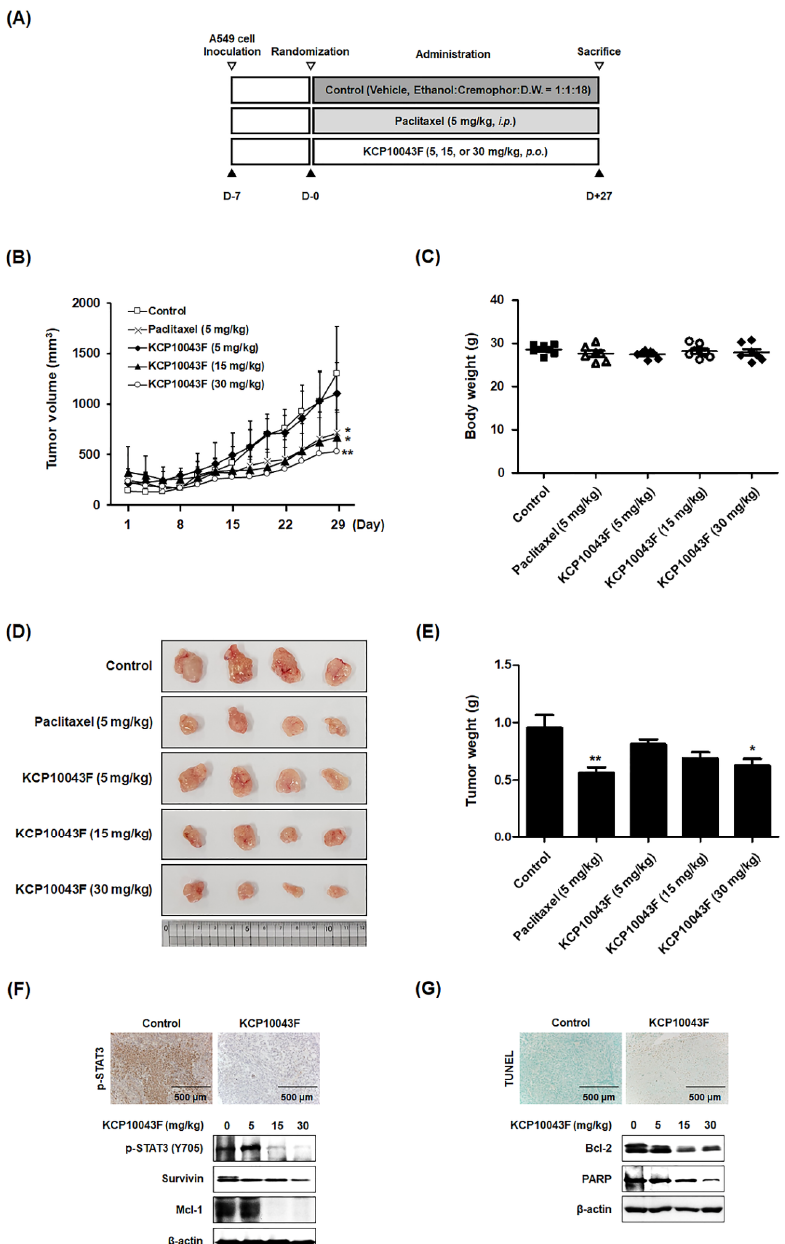
Figure 7. Antitumor effects of KCP10043F in human lung cancer xenograft mouse model by the induction of apoptosis. ( A ) Experimental design of the in vivo A549 xenograft model. A549 cells were subcutaneously inoculated into 7 ‐ week ‐ old BALB/c nude mice ( n = 7 per group), and the mice were treated orally with the vehicle (every day for 5 days), paclitaxel (5 mg / kg, once every 3 days), or KCP10043F (5, 15, or 30 mg / kg, every day for 5 days) for 27 days. ( B ) Tumor volume (mm 3 ) and ( C ) body weight (g) were measured throughout the experimental period. ( D ) The tumors were separated and ( E ) weighed after the mice were sacrificed. ( F ) Immunohistochemical staining of p-STAT3 in the tumor sections was performed. Tumor tissues were homogenized at 27 days after KCP10043F treatment, Western blot analysis showed the inhibition of p-STAT3 (Y705), survivin, and Mcl-1 in whole cell extracts from mice tissue. β -actin was used to verify equal protein loading. ( G ) Apoptosis induction was examined by TUNEL assay using tumor sections. After the administration of KCP10043F for 27 days, tumor tissues were homogenized and lysed to prepare the whole proteins for Western blotting analysis detecting the protein expression of Bcl-2 and PARP. β -actin was used as an internal